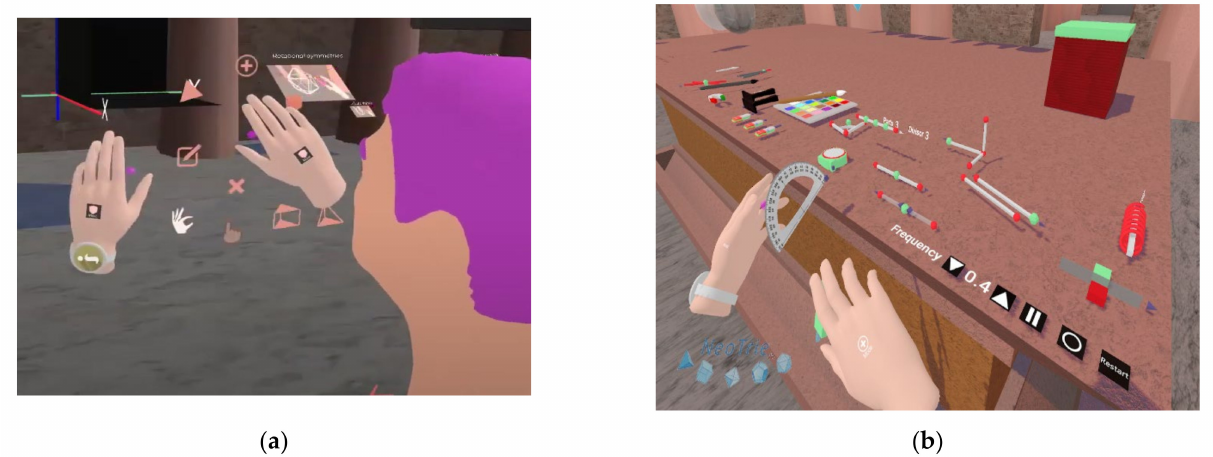
Figure 1. ( a ) Virtual hands action menu. ( b ) Basic actions and